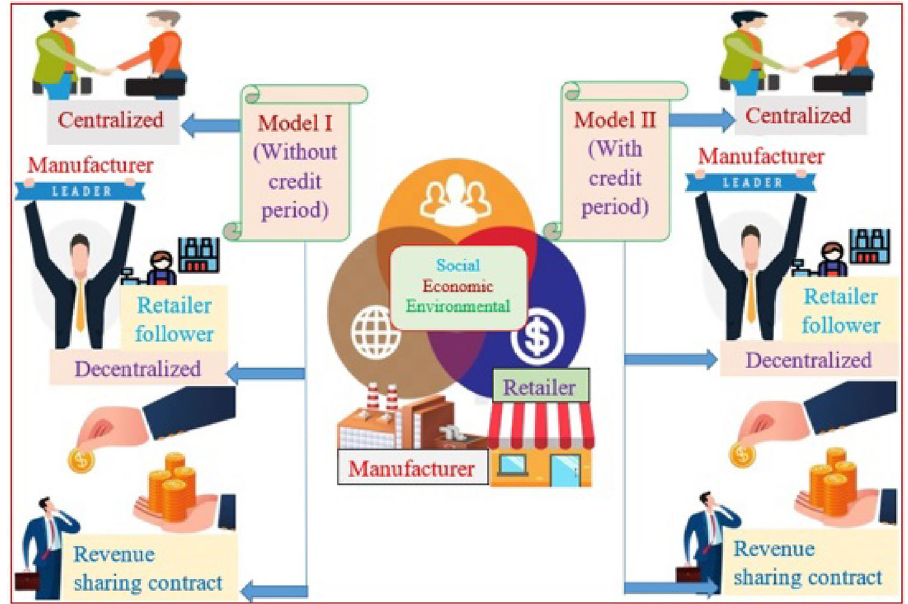
Fig. 1 Developed sustainable supply chain